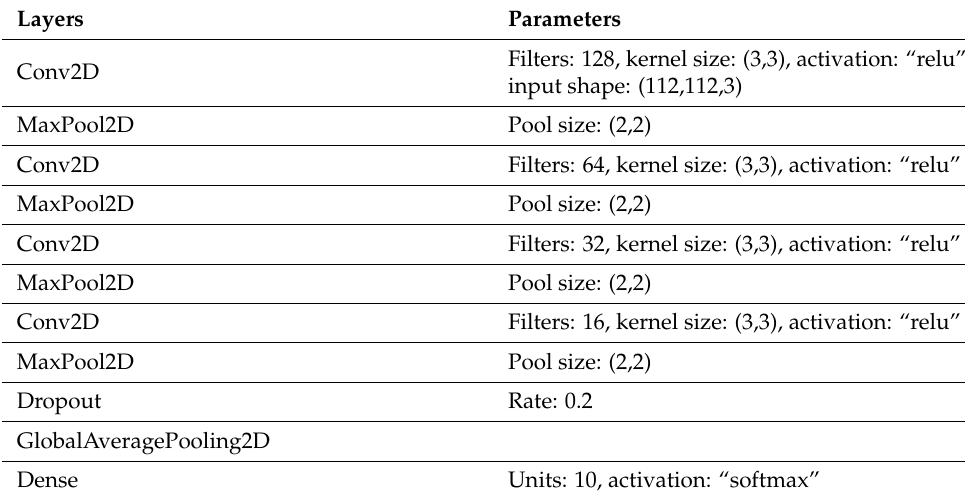
Table 1. Information on the layers structure of the proposed model.